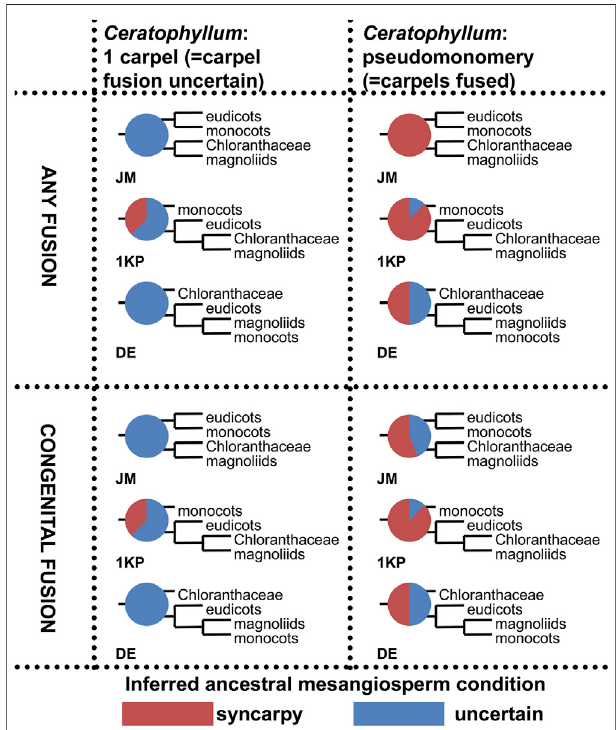
FIGURE 13 | Summary of ancestral state reconstructions with parsimony of fusion between carpels in mesangiosperms on different tree topologies and with two types of coding for the state ‘ syncarpy ’ (any fusion = carpelfusionmaybecongenitalorpostgenital;congenitalfusion=carpel fusion concerns only congenital fusion) in angiosperms. For more detail, see Supplementary File 2 . Each pie chart shows the ratio between inferred ancestral mesangiosperm conditions among 32 tree topologies that differ in placement of Ceratophyllum , Nuphar , Euptelea and To fi eldiaceae. Each diagram shows what pattern of relationships between monocots, eudicots, magnoliids and Chloranthaceae was fi xed in each set of 32 tree topologies.